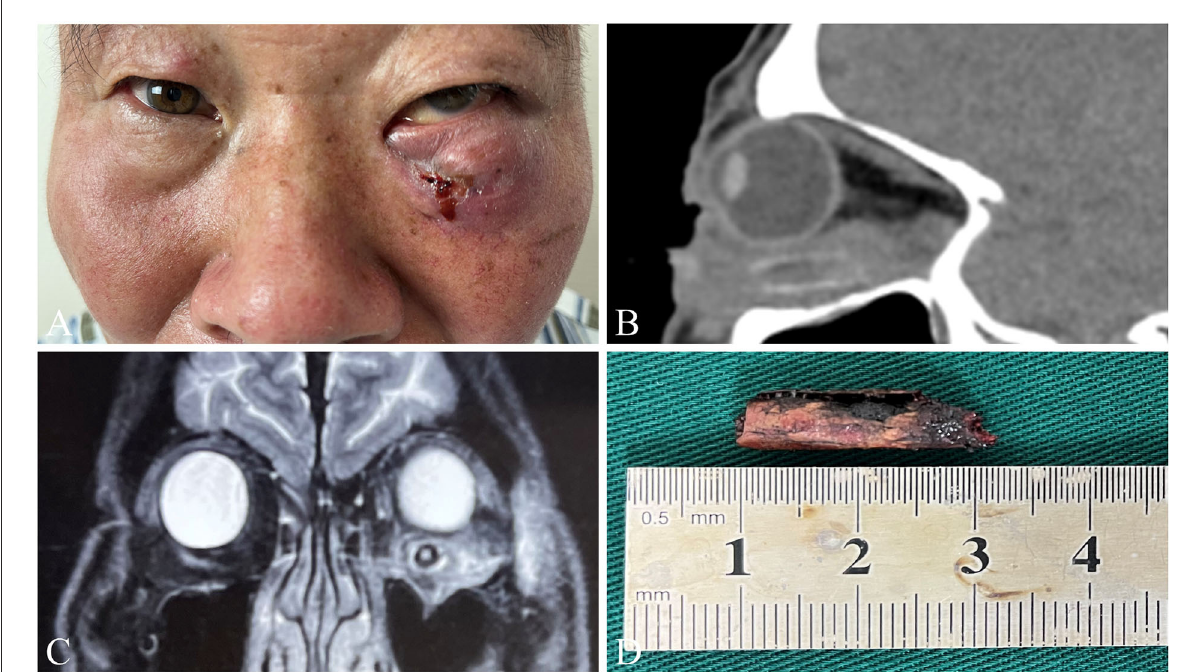
FIGURE2 A representative case of IOWFBs. A 55-year-old man who suffered pain and swelling in his left eye after being injured by a branch and received two separate debridement operations to remove multiple branch fragments at a local hospital. A month after the second operation, he was transferred to our hospital for a thorough examination and treatment as his would worsened. (A) Since a fistula with mucinous secretions in the lower eyelid was exhibited, he was admitted to our hospital 1 month after the second operation. (B) The sagittal CT scan showed a high-density shadow under the left eyeball, with a size of about 20 × 6mm. (C) MRI detected a hollow columnar shadow below the inferior rectus muscle of the left eye. (D) A branch ∼ 20mm long was taken out by exploratory